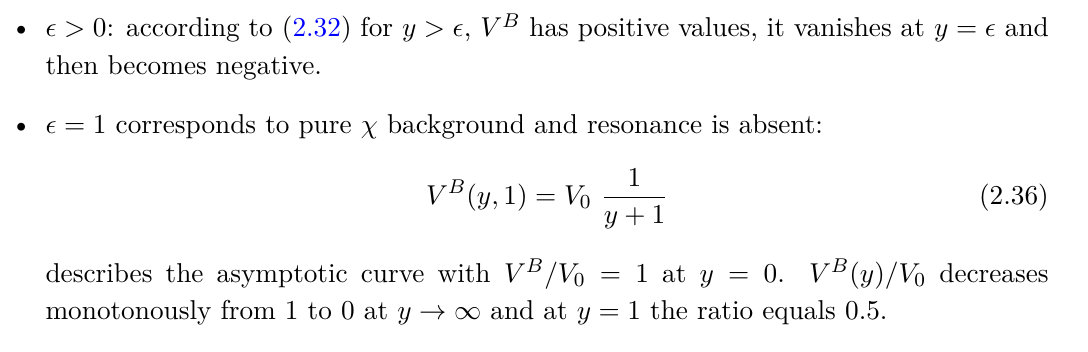
as function of y 0